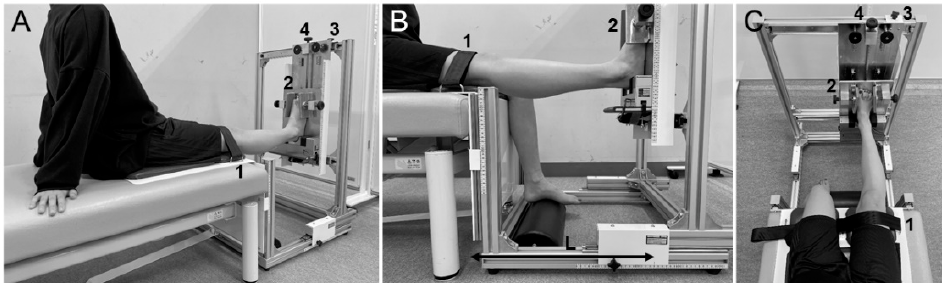
Figure 3. Position for measurement of genu recurvatum. 1: Knee-fixation belt; 2: foot width fixing part; 3: right/left adjustment of lower limbs; 4: foot elevation screw; L, length from center of knee to heel. The participant was seated on the hyperextension apparatus (Takei Scientific Instrument Co., Niigata, Japan) in a long sitting position with the hip joint set in about 70 ◦ of flexion with both upper limbs behind them ( A ). Distance from the knee to the heel was adjusted by placing the heel on the footrest ( B ), and positions of the lower limbs were adjusted to the left/right to achieve 0 ◦ of hip adduction ( C ). The proximal patella was fixed with the knee-fixation belt, and foot width was also fixed. Participants were instructed in advance to signal just before the appearance of pain or discomfort in the knee joint, and the knee joint was extended by turning the foot elevation screw at a rate of approximately 1 ◦ · s − 1 or less until that signal was given. At the time the signal was given, foot height was recorded. Maximum angle of passive knee joint extension was calculated later based on the result recorded.